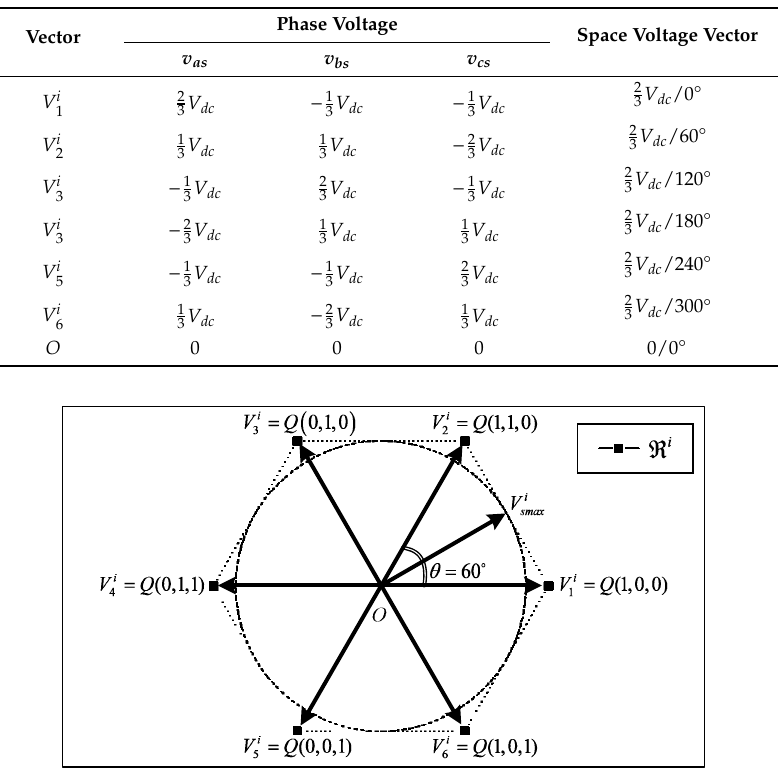
Table 1. The phase voltages and space voltage vectors of the typical three-phase VSI.